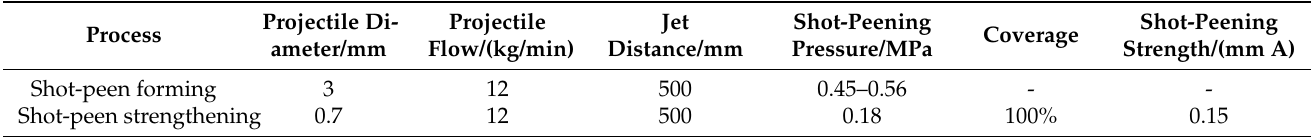
Table 2. Process parameters of shot-peen forming and shot-peen strengthening.